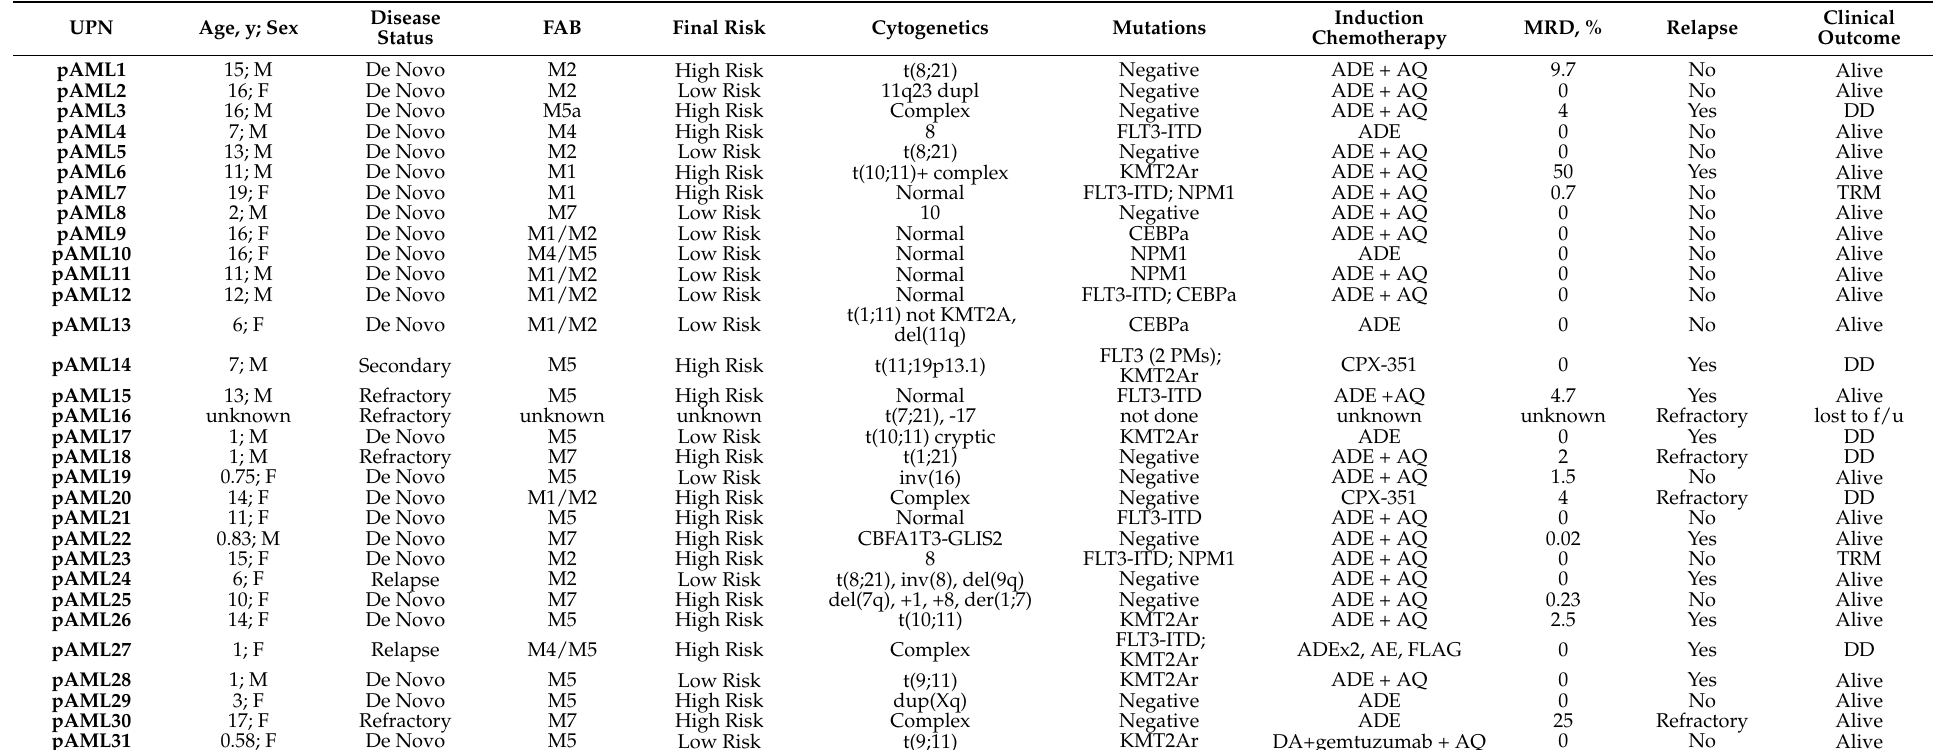
Table 1. Patient data by UPN. Thirty-one patients were profiled using the ex vivo drug sensitivity platform. Age is shown in years at time of initial diagnosis. Mutations tested: FLT3-ITD, NPM1, CEBPA, and KMT2Ar. Minimal residual disease (MRD) was measured by flow cytometry following the end of induction. Clinical outcome indicates status at last contact. UPN, unique patient number; F, female; M, male; FAB, French-American-British; NR, not reported; ADE, cytarabine/daunorubicin/etoposide; AQ, atovaquone; CPX, CPX-351; AE, cytarabine/etoposide; DA, daunorubicin/cytarabine; DD, death from disease; f/u, follow-up; TRM, treatment-related